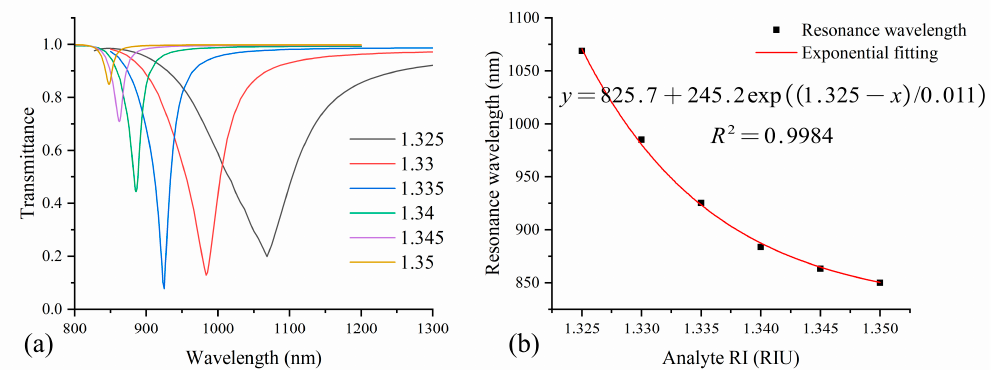
Figure 9. ( a ) The resonance spectra of the proposed sensor with different analyte RI values. ( b ) The relationship between resonance wavelength and the changing RI values. The simulation parameters are: r = 3.5 µ m, R = 20 µ m, g = 60 nm, t = 50 nm, d = 1 µ m.